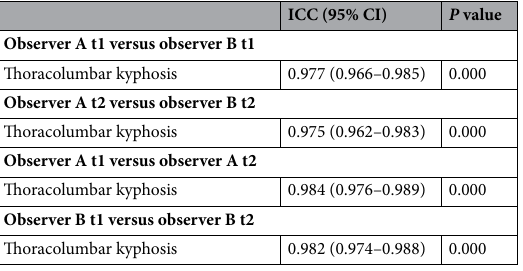
Table 3. Inter- and intraobserver reliability of observer A’s versus observer B’s measurements using smartphone. Observer A t2: the results of the second time of observer A, and so on. Observer B t1: the results of the first time of observer B, and so